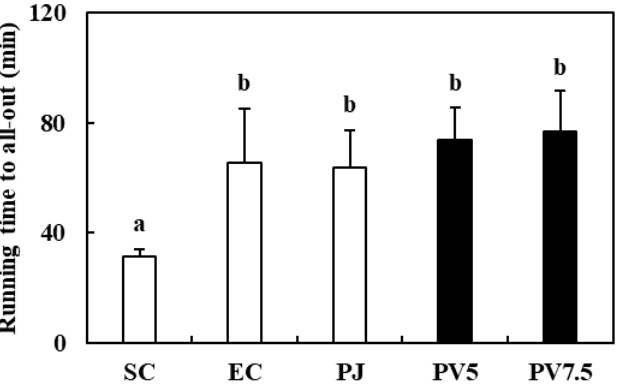
Figure 3. Effect of PV on running endurance time. Data values are expressed as the means ± S.E. ( n = 6). SC: sedentary control, EC: exercised control, PJ: Prunus mume juice, PV5: 5% Prunus mume vinegar drink, PV7.5: 7.5% Prunus mume vinegar drink. Different letters on the bar are significantly different ( p < 0.05).